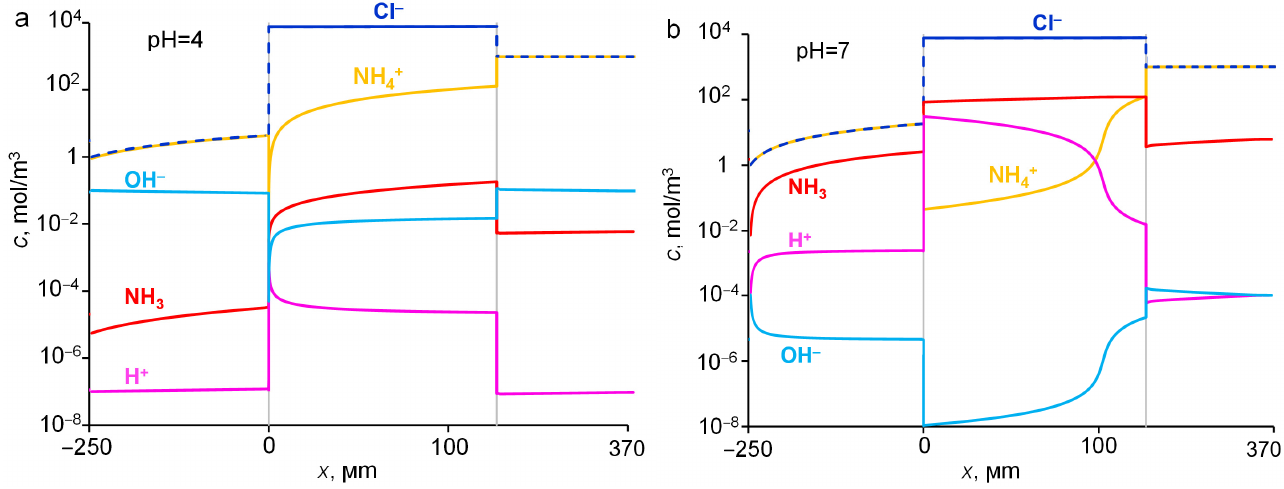
Figure 10. Distribution of species concentrations in the system under study at pH = 4 ( a ) and pH = 7 ( b ) of the 1 M NH 4 Cl feed solution. Simulation: the input parameters are presented in Table 1.